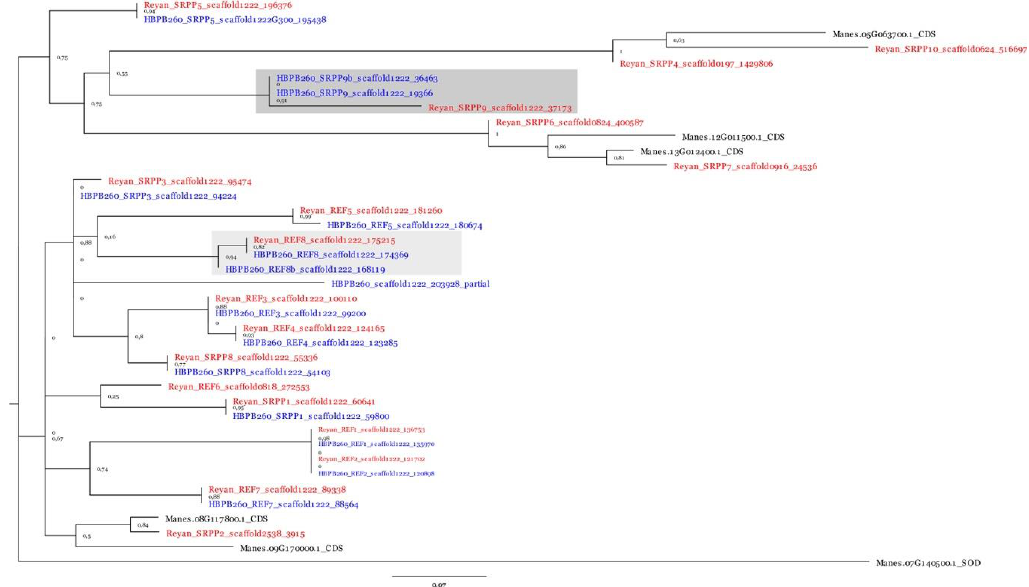
Figure 7. Phylogenetic analysis of the nucleotide sequences of the REF/SRPP genes present on scaffold 1222 (Reyan 7-33-97 in red and PB 260 in blue). Manihot esculenta SRPP genes were added, as well as a superoxide dismutase gene ( SOD ) as an out-group. Local gene duplication in Reyan 7-33-97 when compared to PB 260 were shaded in light grey.